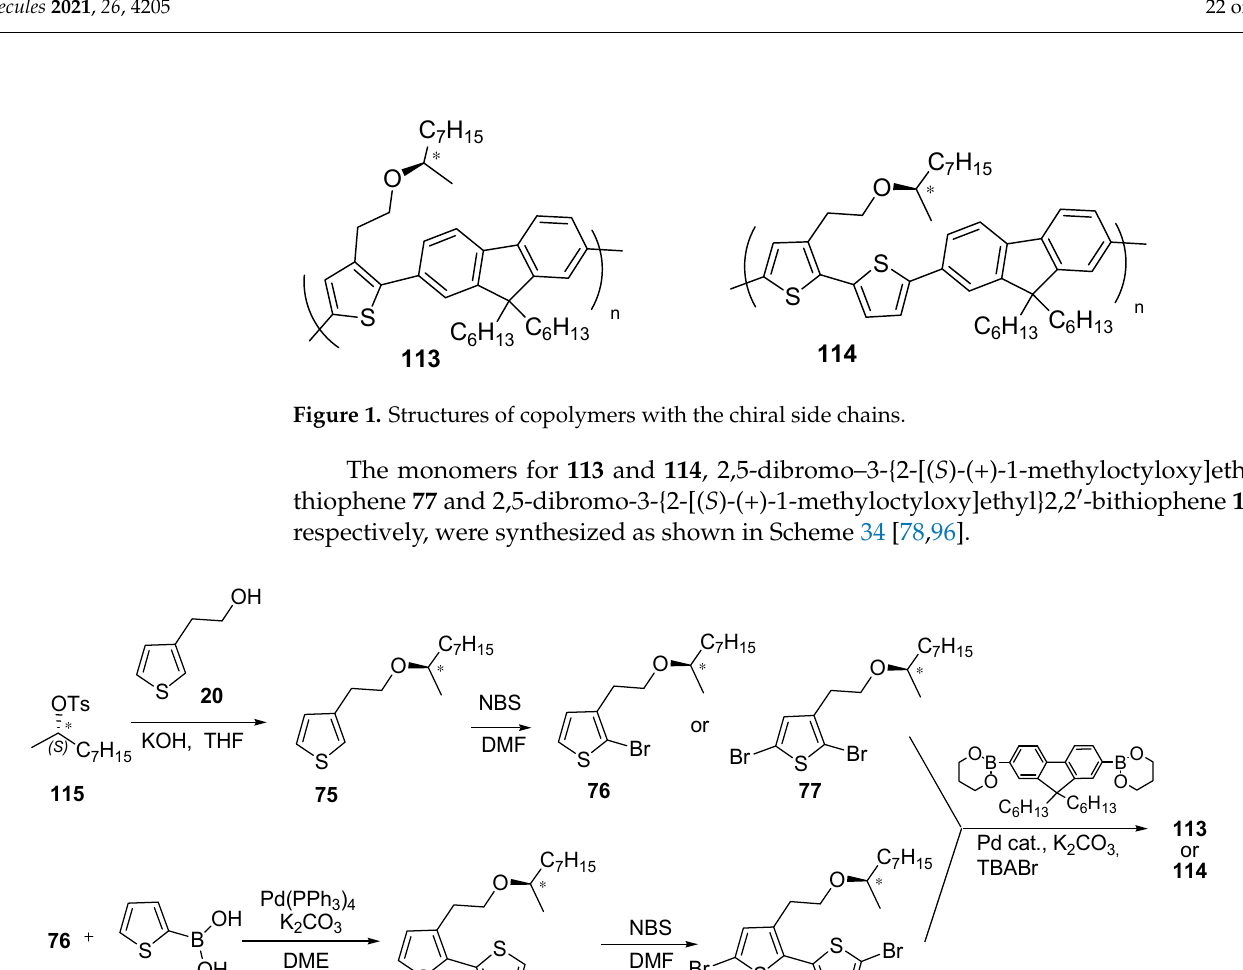
Scheme 34. Synthesis of 2,5-dibromo-3-{2-[( S )-(+)-1-methyloctyloxy]ethyl}-2,2 ′ -bithiophene ( 117 ) as a precursor for copolymerization with 9,9-dihexylfluorene-2,7-bis(trimethylene boronate).